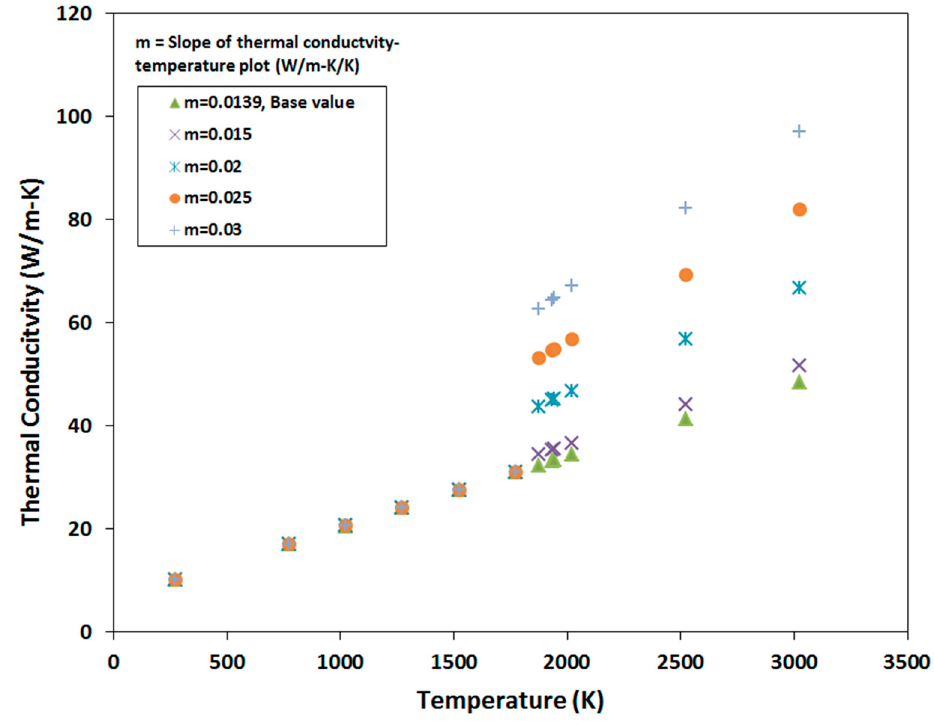
Figure 12. Slope of thermal conductivity data after the melting point is varied.